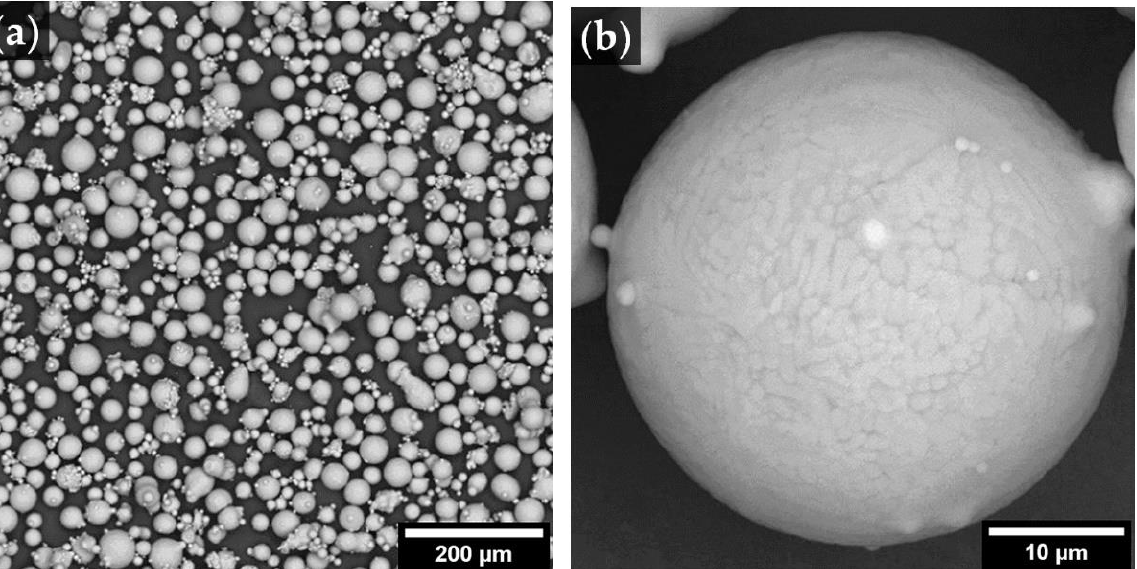
Figure 2. SEM images of RS-333 powders: ( a ) general view and ( b ) single particle microstructure.